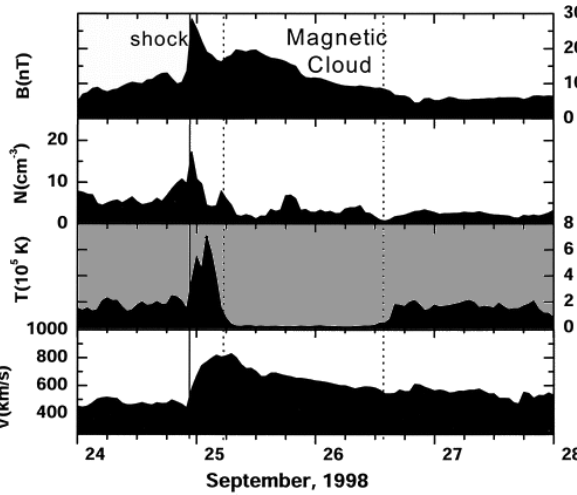
Fig. 11. Actual in situ measurements of a magnetic cloud near 1AU, adopted from Burlaga et al. (2001). The general shape of these profiles is to be compared with the simulation results depicted in Fig.